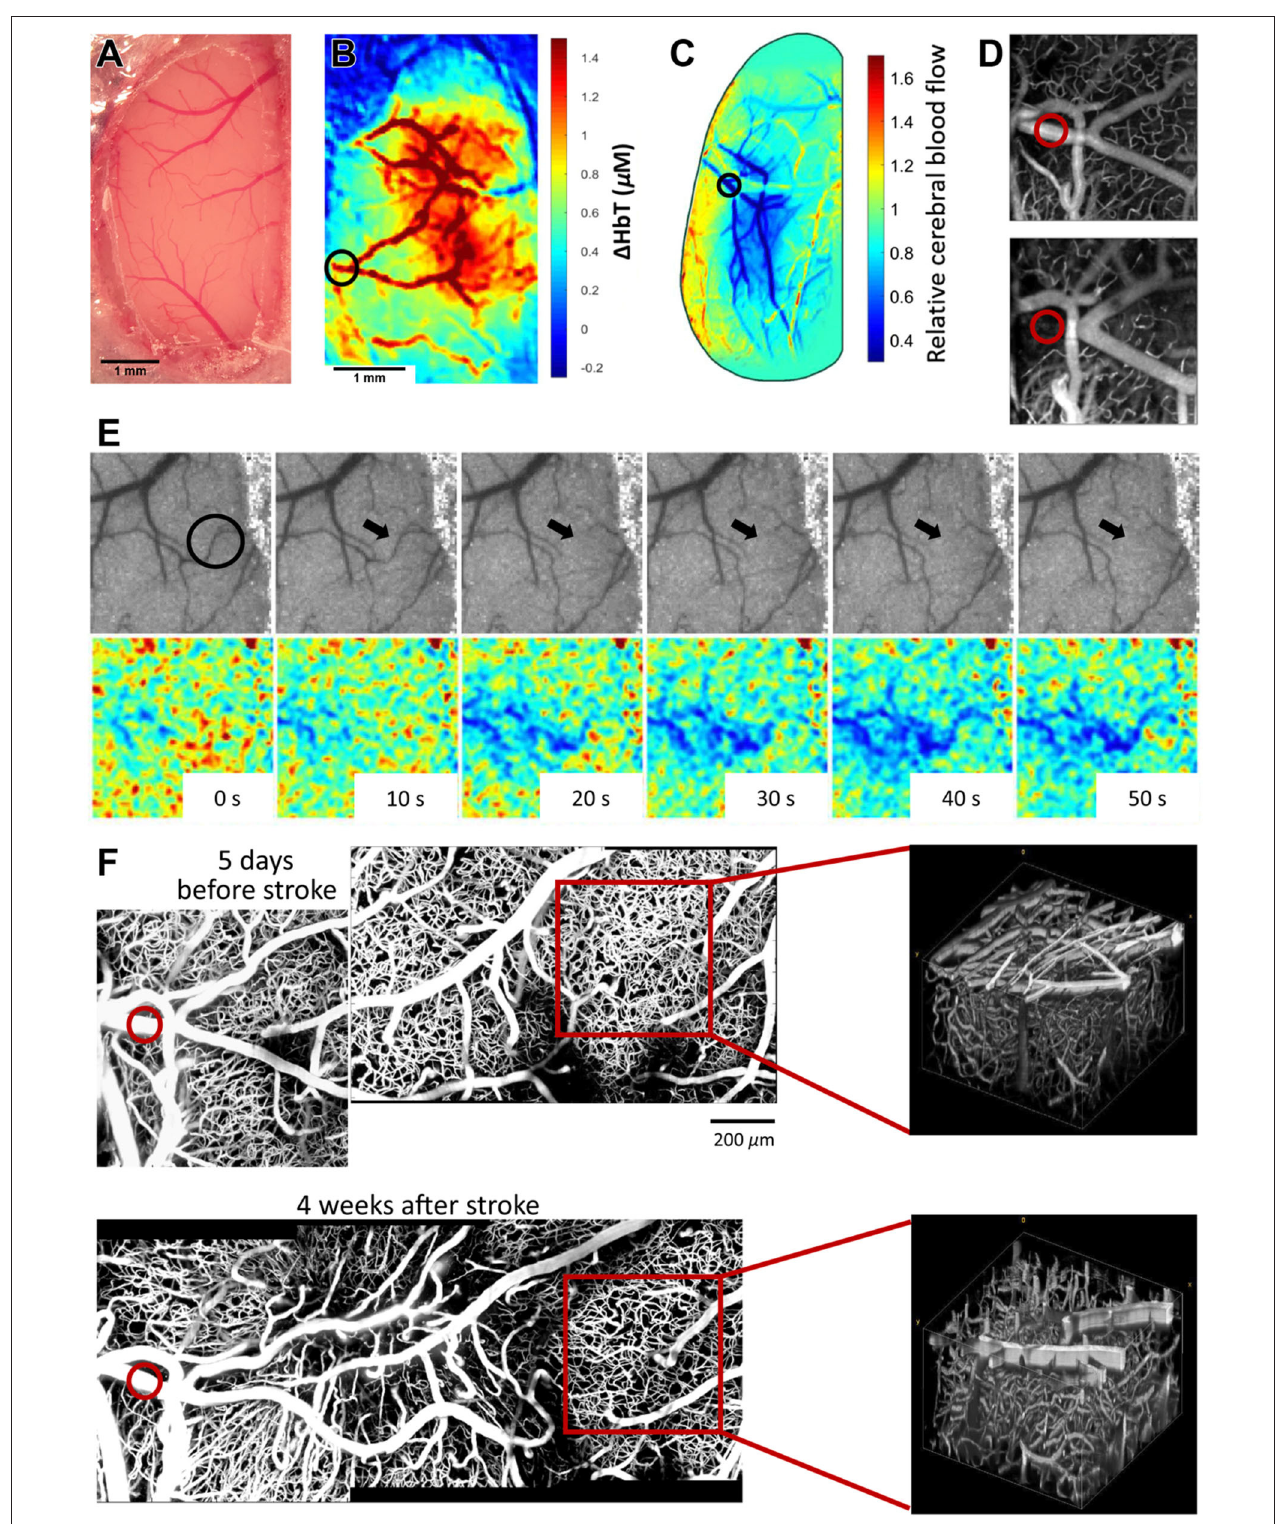
FIGURE 2 | (A) Representative image of cranial window immediately after surgery. In this preparation, animal was implanted with a one-point secured flat head bar and half Crystal Skull glass (please see Supplementary Material for details). (B) Intrinsic optical signal imaging of change in total hemoglobin concentration during